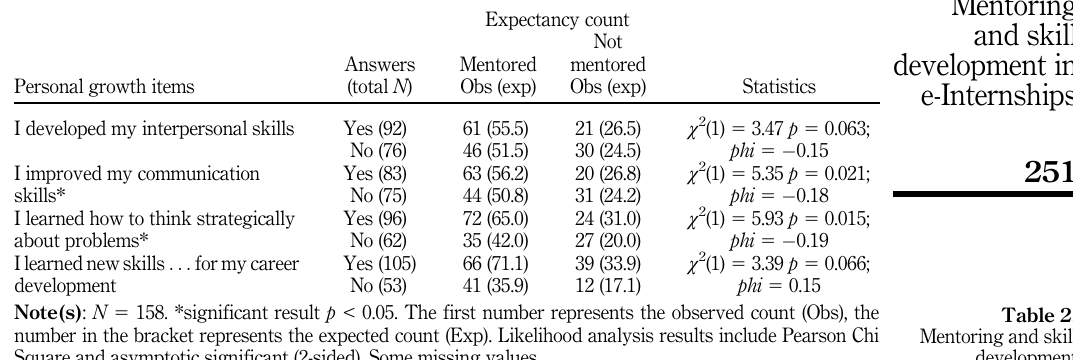
Table 2. Mentoring and